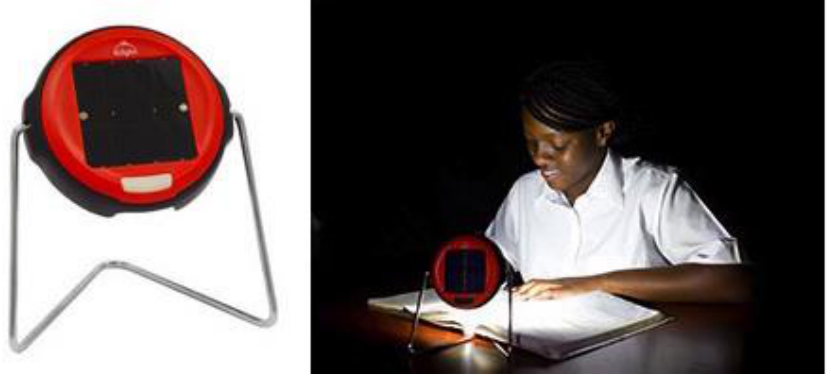
Figure 13. The D.Light ® S2 solar LED lantern has replaced a million kerosene lanterns in Africa [36]. Redundancy and responsibility are also important. Children with D.Light ® S2s have their own personal solar devices. If there are five D.Lights in a family and one personal unit fails or is stolen, there are still four working units that the family can share until a replacement is acquired.